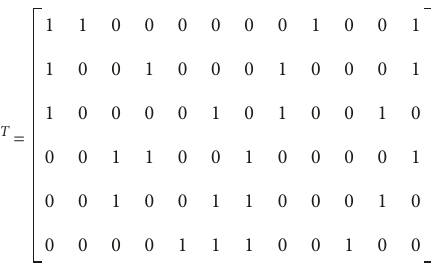
Figure 1: Test traffic network. Table 1: Link-route incidence matrix.